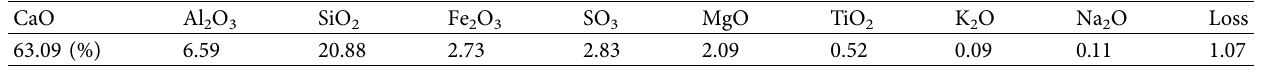
Table 1: Chemical composition of cement